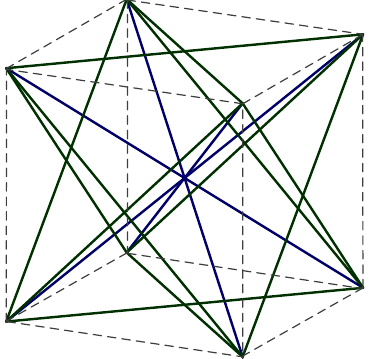
Figure 1. Ground structure schematic.